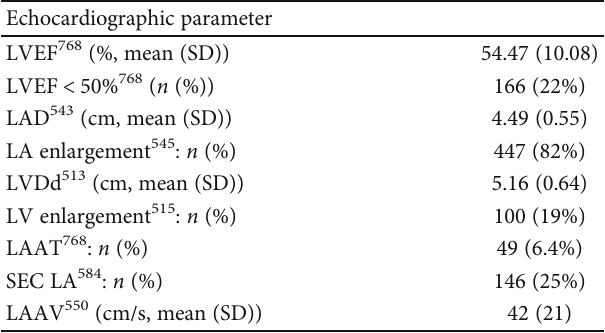
Table 2: Echocardiographic fi ndings of the study population. Echocardiographic